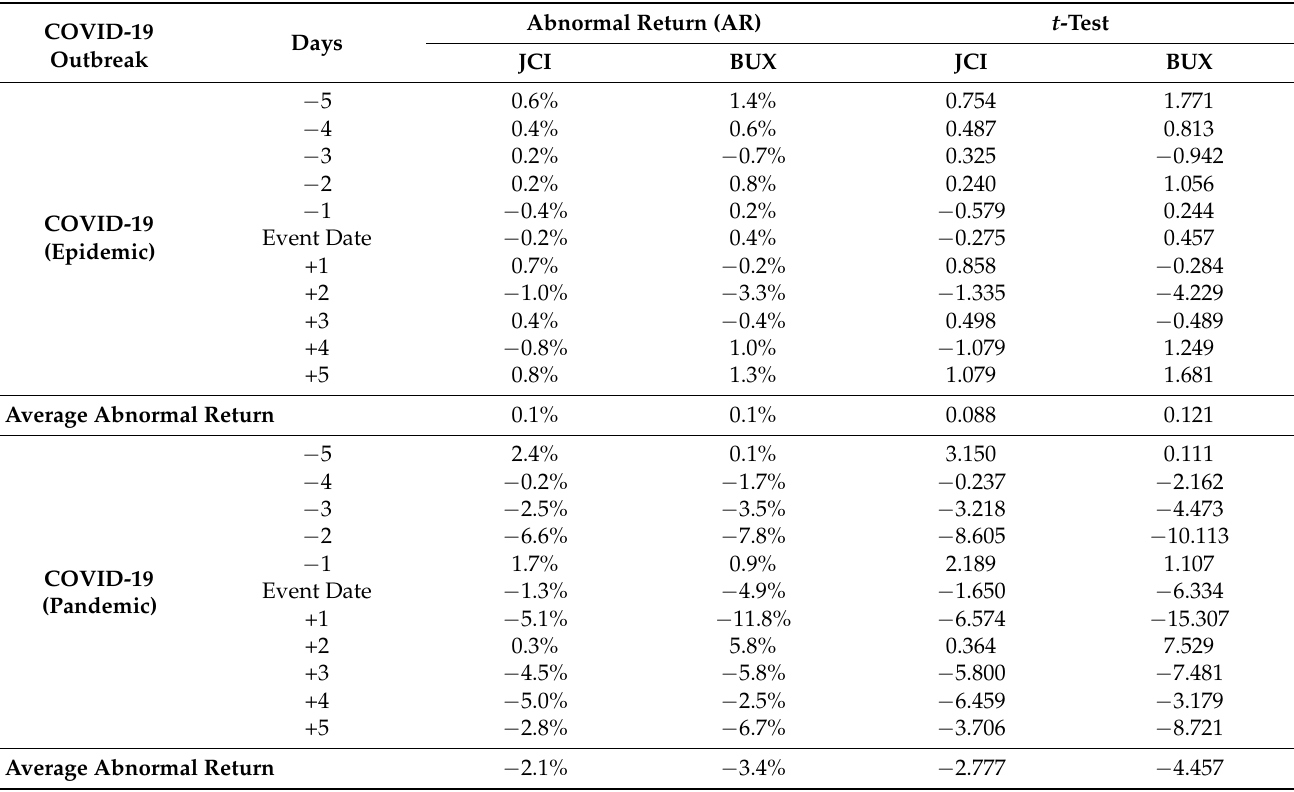
Table 4. The JCI and BUX Abnormal Return and t -test during COVID-19